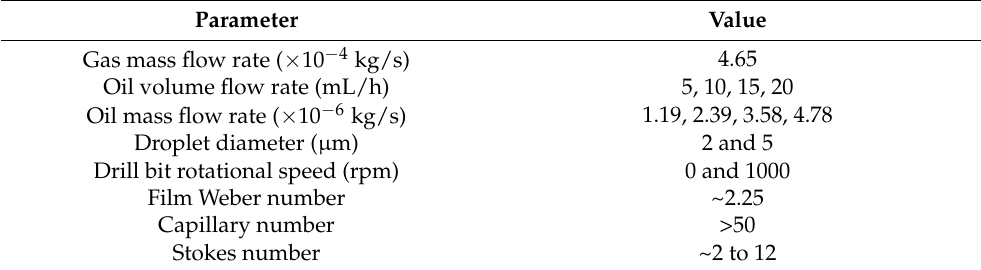
Table 2. Operating parameters and conditions adopted in the numerical